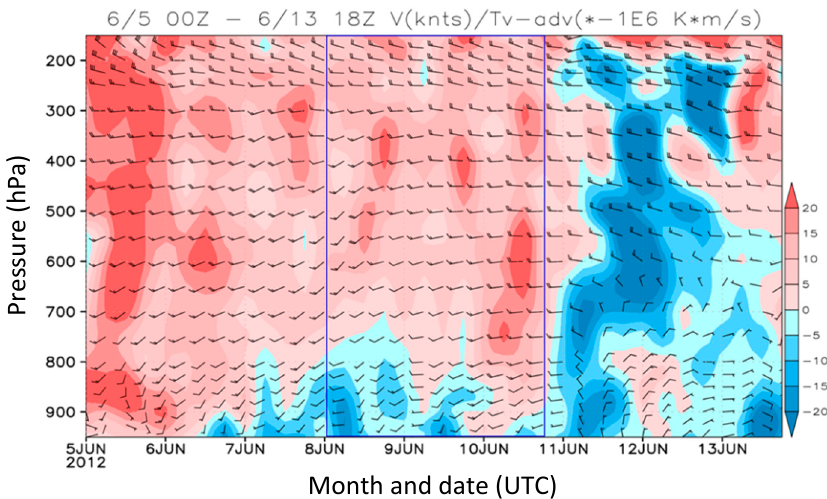
Figure 12. Time-height cross section of virtual temperature advection (color, 10 − 6 K s − 1 ) in South China from the ERA-Interim data, averaged inside the red box in Figure 1, from 0000 UTC 5 to 1800 UTC 13 June 2012. The thin blue box marks the pressure fall period in South China.